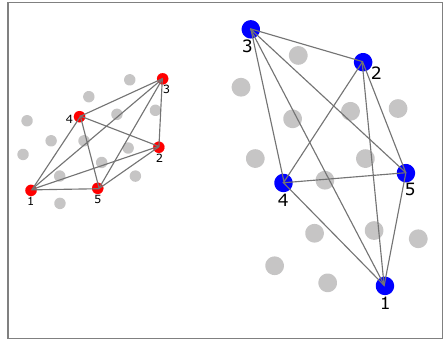
Figure 10. Illustration of the initial scale estimation